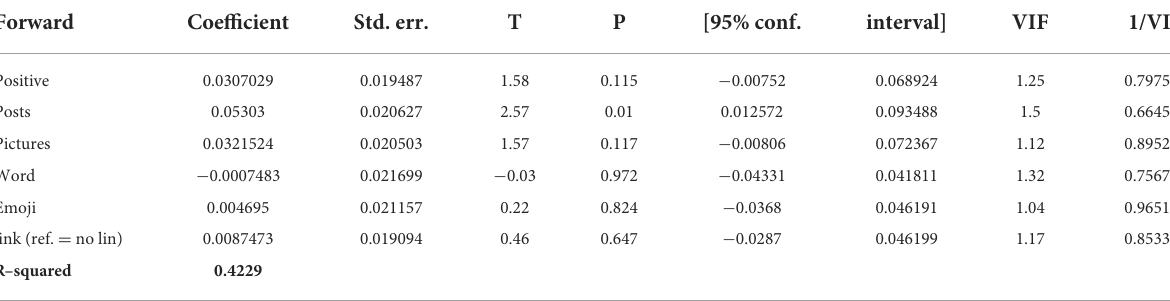
TABLE 12 Multiple linear regression results of positive sentiment regression model.